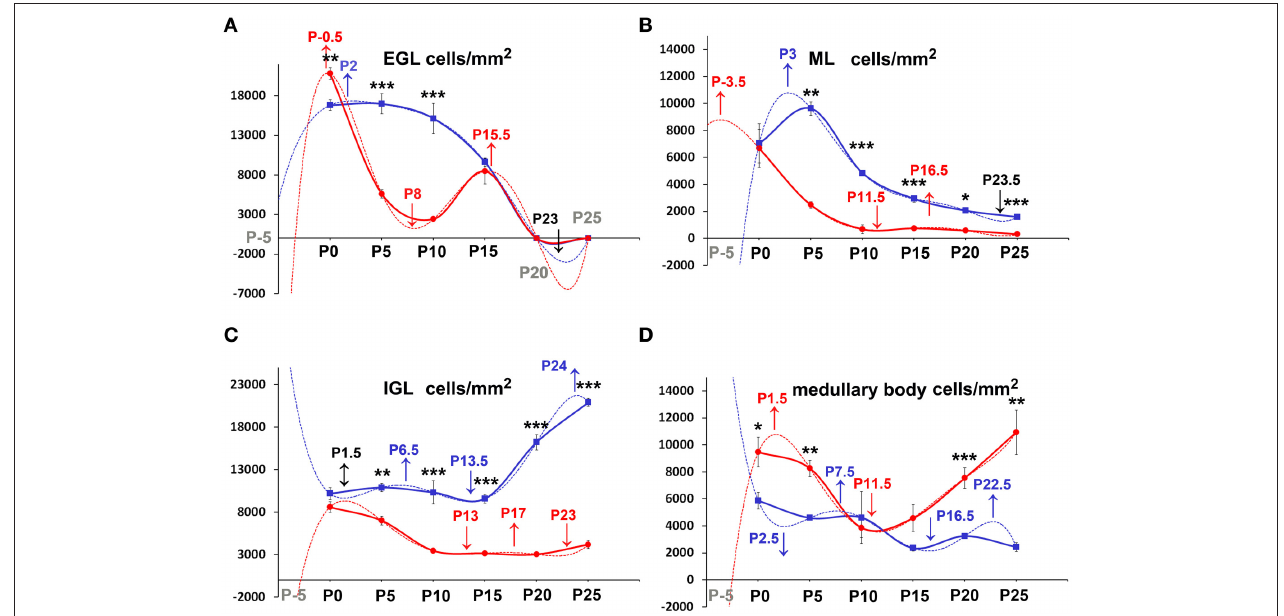
FIGURE 3 | Descriptive graphs (solid lines) and correlation curves (dashed lines) of normalized TCDs in cortical layers and the medullary body. Graphs highlight the trends and differences across genotypes of normalized TCDs in the four cerebellar compartments defined in this study. Postnatal ages corresponding to the minima and maxima of correlation curves are indicated with colored letters and upwards or downwards arrows. Blue and red lines or letters/arrows refer to reln + / + and to reln − / − mice, respectively. Black letters for postnatal ages and arrows (A–D) refer to both genotypes. Postnatal ages in gray (x axis) indicate the time points of correlation curves outside the sampling interval (extrapolations). In reln + / + mice, TCD decreased in function of time after an interpolated positive peak at P2 in the EGL ( A , blue dashed line) and at P3 in the ML ( B , blue dashed line), whereas it increased in the IGL with an interpolated peak at P24 ( C , red lines), and displayed an oscillatory trend in the medullary body ( D , red lines). Although a decrease also occurred in the reln − / − EGL ( A , red lines) and ML ( B , red lines), descriptive and correlation curves were notably different when compared to those calculated for reln + / + mice. Extrapolated peaks at P0.5 (EGL) and P3.5 (ML) occurred earlier than in normal mice ( A , B , dashed red and blue lines respectively). At P15, TCD in Reeler mouse EGL displayed a positive peak ( A , solid red line), which did not have a counterpart in normal mice. The negative peaks (extrapolations) of the regression curves between P20 and P25 (in black) are predictive of the factual disappearance of the EGL in both groups of mice. In the IGL, TCD in normal reln + / + mice was progressively increasing ( C , blue lines), while in reln − / − mice it displayed a totally opposite temporal trend, dropping dramatically over time from P5 onward ( C , red lines). Note that, after an extrapolated minimum in reln + / + (blue dashed line) or maximum in reln − / − (red dashed line) at P1.5, a temporal switch of interpolated peaks occurs in the correlation curves of the two genotypes. Also in the medullary body (D) regression curves describing the correlation of TCD with time were very different in reln + / + (blue lines) and reln − / − animals (red lines). EGL, external granular layer; IGL, internal granular layer; ML, molecular layer; P, postnatal age. One-way ANOVA with multiple comparisons; error bars indicate SEM; *** P < 0.001; ** P < 0.01; * P <